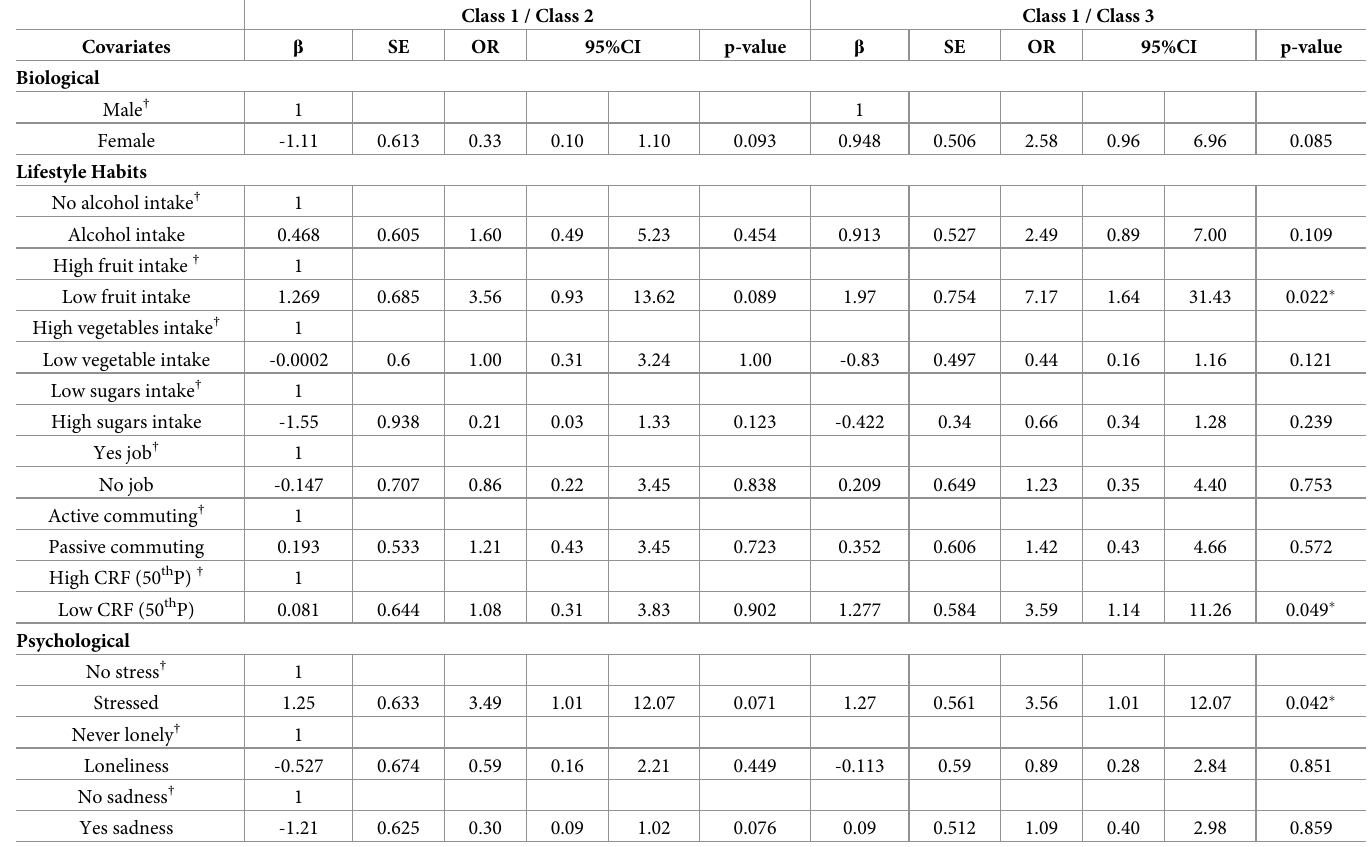
Table 2. Association of individual covariates (biological, life habits, and psychological) with the adolescents’ movement behaviors LCA